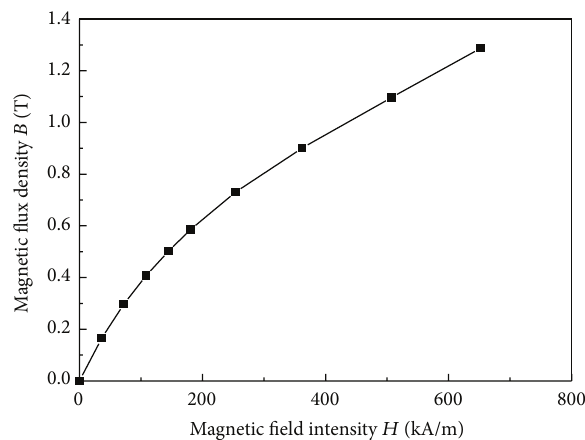
Figure 5: The variation of the magnetic flux density 𝐵 and the magnetic field intensity 𝐻 .